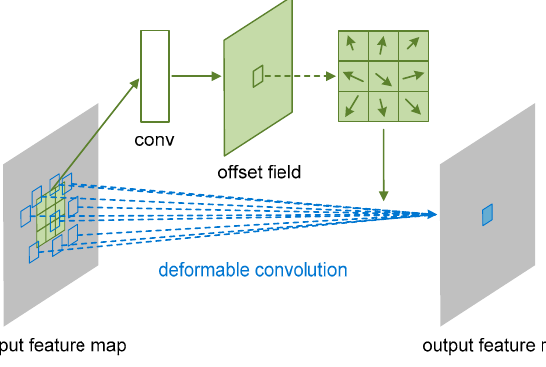
Figure 2. Illustration of 3 × 3 deformable convolution.